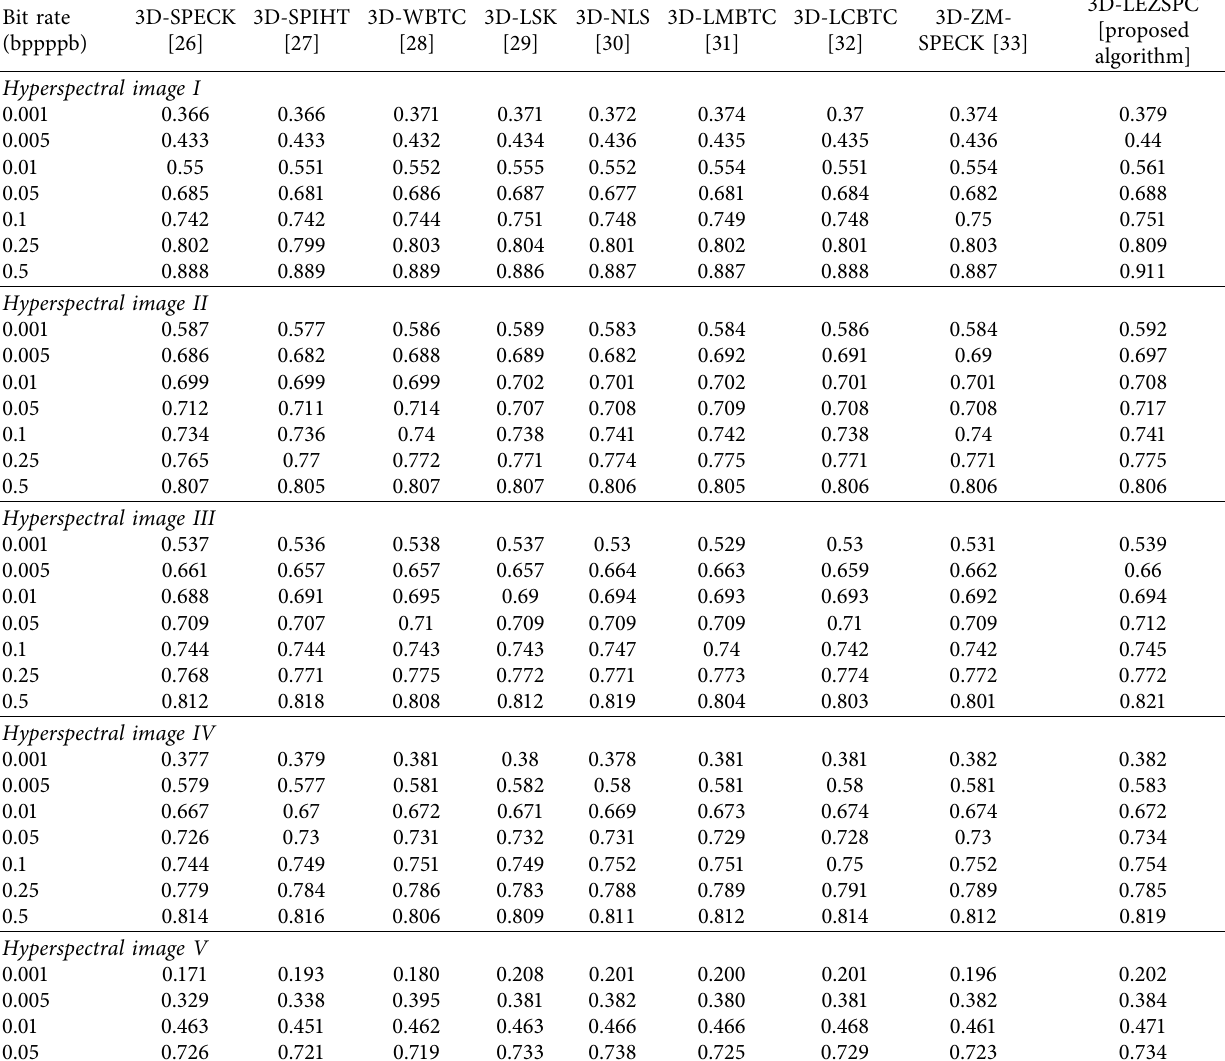
Table 6: Comparative analysis of the feature similarity (FSIM) index between the 3D-LEZSPC with the other wavelet transform based set partitioned HSICA.